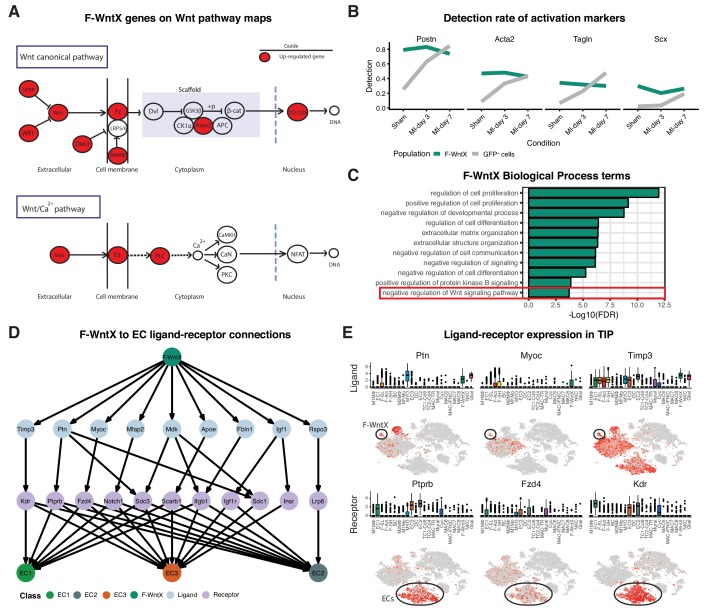
Features of the F-WntX population.(A) Differentially expressed genes in F-WntX overlaid on Wnt pathway maps. Wnt node includes genes Wnt5a and Wnt16. (B) Detection rate, representing the percentage of cells expressing a gene, across all conditions for cells in F-WntX or all GFP+ cells combined. (C) Example GO BP terms over-represented (FDR < 0.05) in genes upregulated in F-WntX compared to F-SL/F-SH populations. (D) Tree plot showing ligand-receptor connections from F-WntX to EC sub-populations as calculated in TIP. Top node refers to source population, second layer to ligands, third layer to receptors and leaf nodes represent target populations. (E) Examples of F-WntX:EC ligand and corresponding receptor expression as visualised in box and t-SNE plots. For each ligand the corresponding receptor is immediately below.